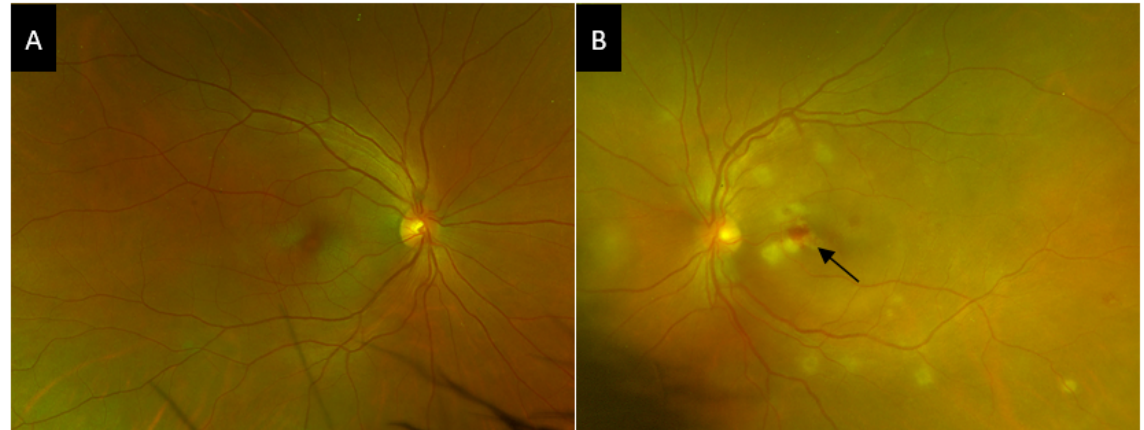
Figure 3. Wide field fundus photograph of the right eye of the case 2 patient. ( A ), Widefield fundus photograph of the right eye showing no signs of intermediate or posterior uveitis. ( B ), Widefield fundus photograph of the left eye showing multiple patchy subretinal white spots and a nodule of retinal necrosis with hemorrhage (black arrow).